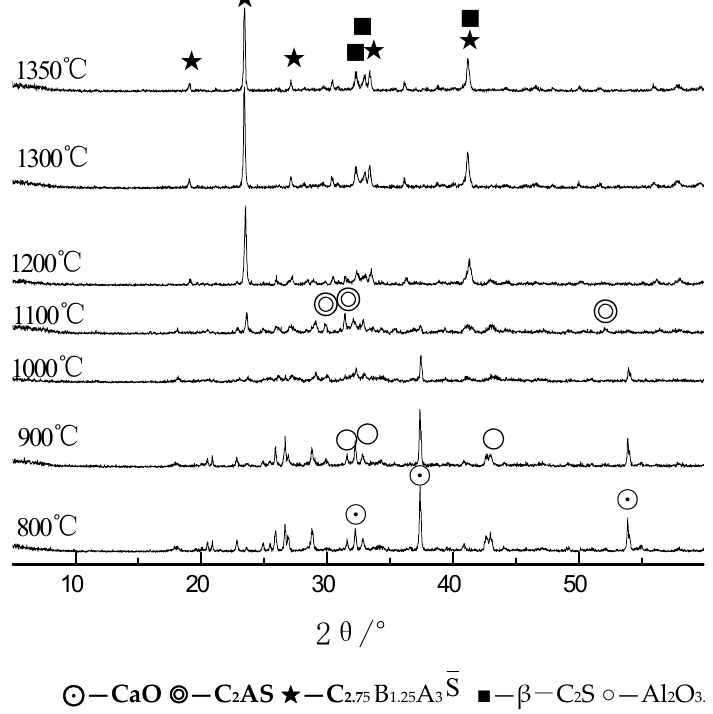
Figure 4. XRD patterns of sample F3 at different temperatures.